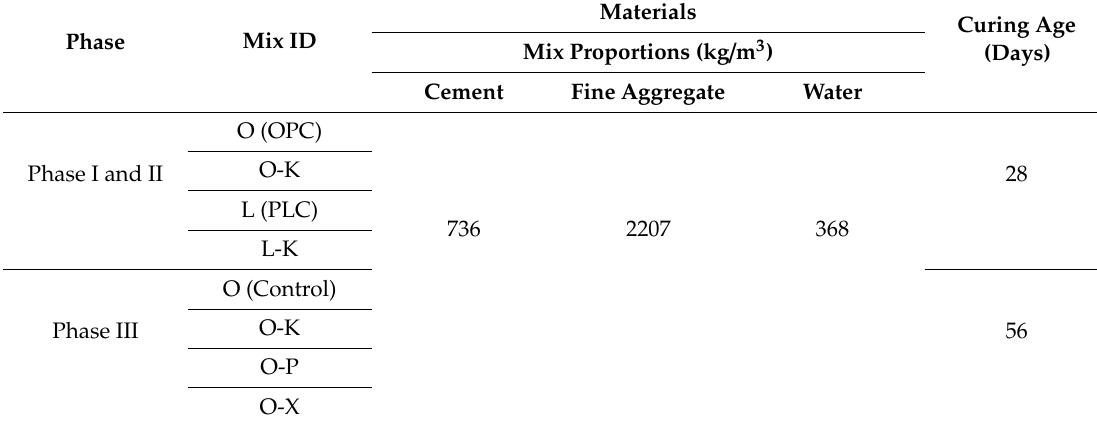
Table 2. Cementitious composite mix design and